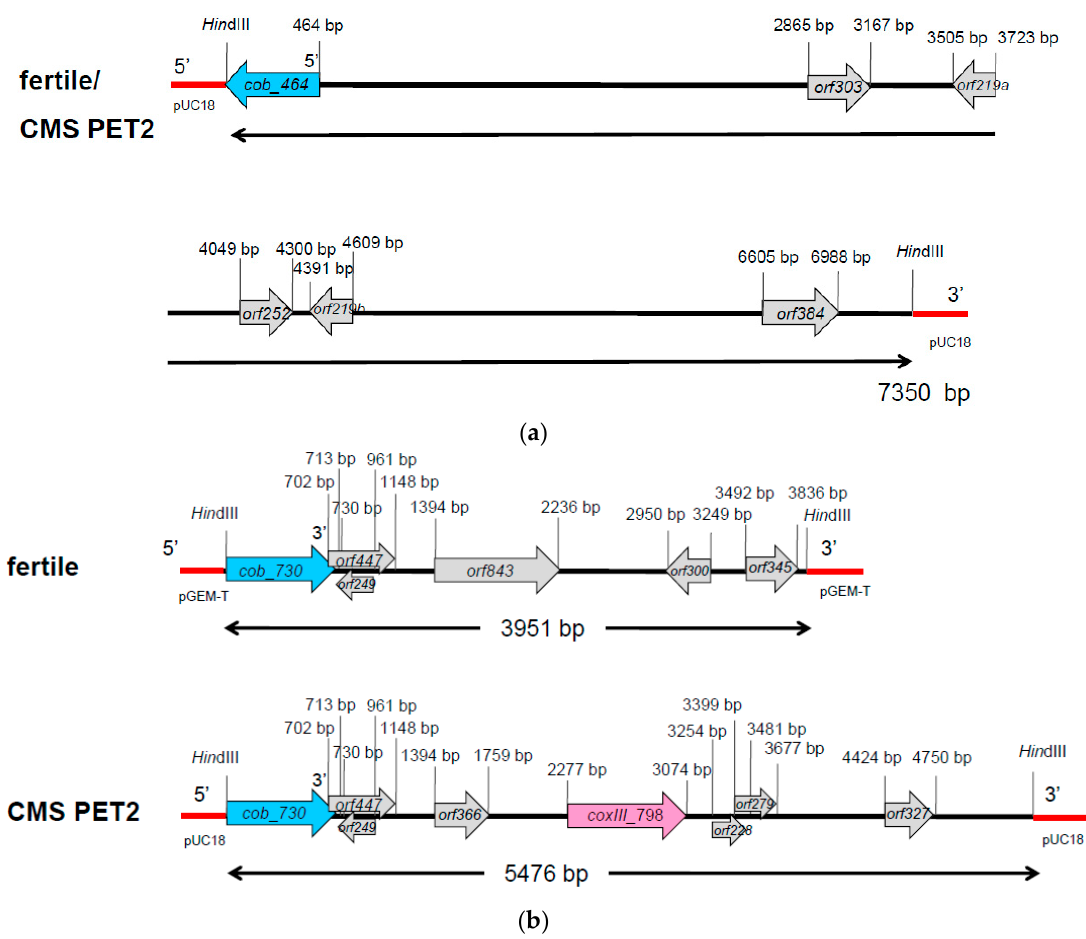
Figure 5. Comparison of the organization of the open reading frames on the hybridization fragments obtained by using cob as probe in the normal, fertile HA89 and CMS PET2. ( a ) 5 ′ cob fragment (7.3 kb) of fertile cytoplasm and CMS PET2, ( b ) 3 ′ cob fragment for the fertile cytoplasm (3.9 kb) and CMS PET2 (5.5 kb).